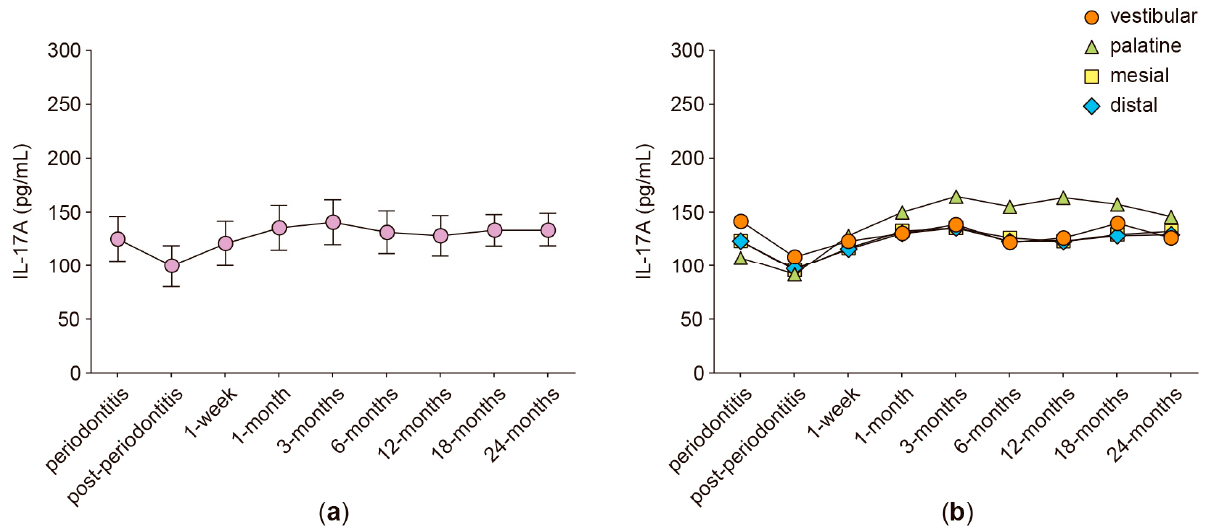
Figure 5. IL-17A levels. ( a ) IL-17A levels detected in the gingival crevicular fluid of periodontally compromised anterior teeth before periodontitis treatment (periodontitis), after periodontitis treatment (post-periodontitis), and during 2 years of patient-specific orthodontic treatment (1 week to 24 months), using intermittent low-intensity orthodontic forces. Data are represented as pg/mL and shown as mean ± SD. ( b ) IL-17A levels detected in each periodontal site, analyzed at the same time-points described in ( a ).